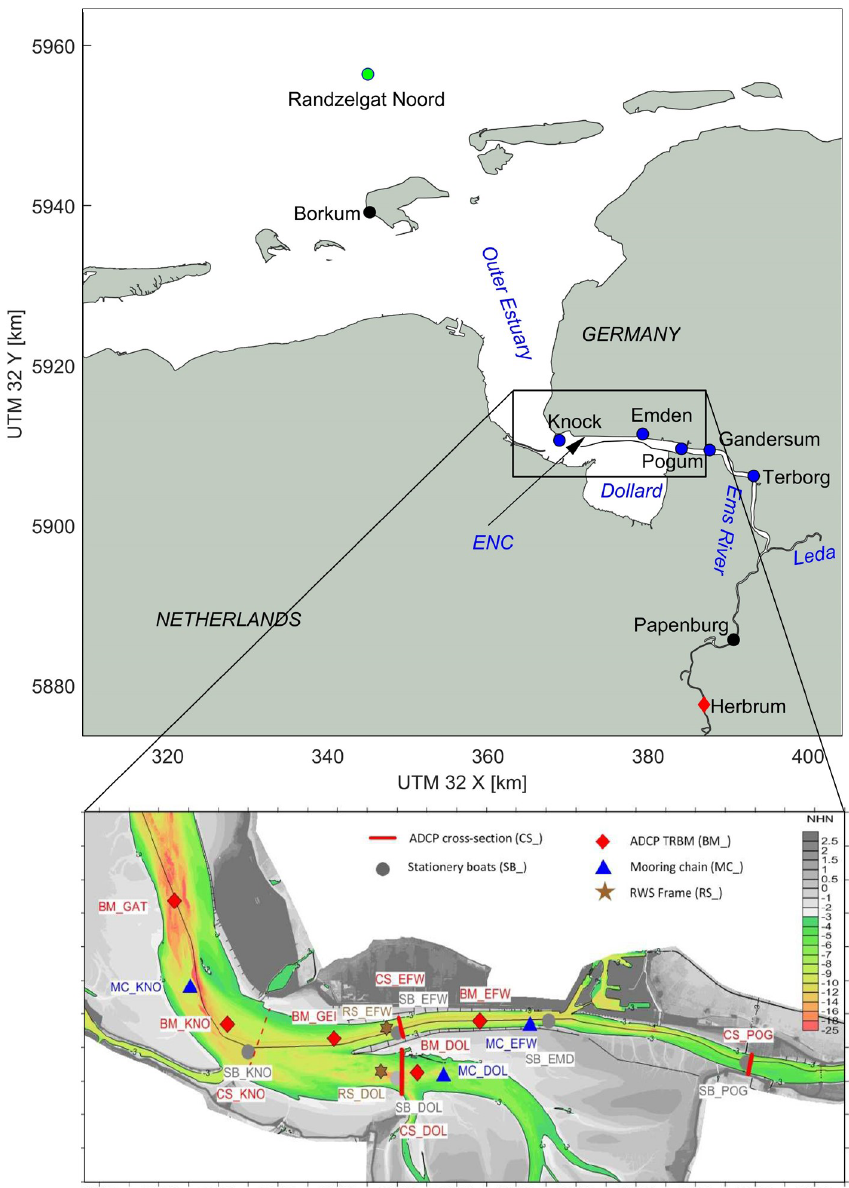
Figure 1. Location of all observation stations during the EDoM campaigns. Top panel: Main water bodies referred to in this document (blue text) with long-term mooring stations (black text). The green station measures wave height, the blue stations measure water levels, SSC, salinity, oxygen, and temperature; the black stations (Borkum and Papenburg) are the end of the longitudinal transect sailed during the 13h surveys. The diamond denotes the weir at Herbrum and for which the discharge measured at Versen (further landward) is used as river discharge. Lower panel: detail with stations occupied during the EDoM campaigns (see Table 1 for explanation of